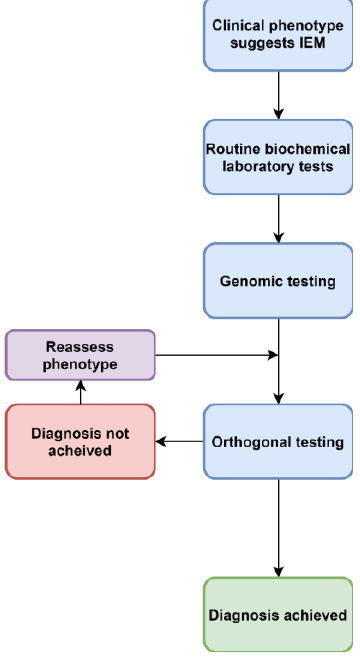
Figure 2. An evolving approach to diagnoses of IEM.